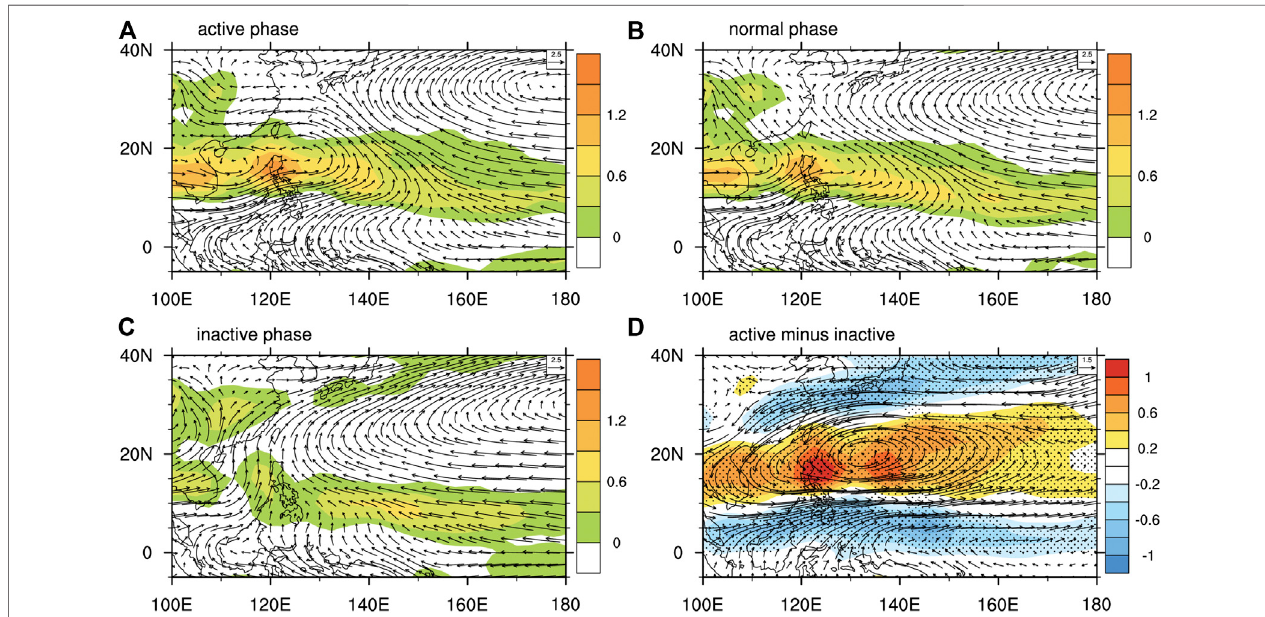
FIGURE 2 | The composite wind fi elds and vorticity fi elds (shading, 10 – 5 s − 1 ) at 850 hPa of the typical events in the (A) active phase, (B) normal phase, and (C) inactive phase. (D) The vorticity difference (shading) of typical events in the active phase minus those in the inactive phase. The dots represent values signi fi cant at the 95% con fi dence level using the t